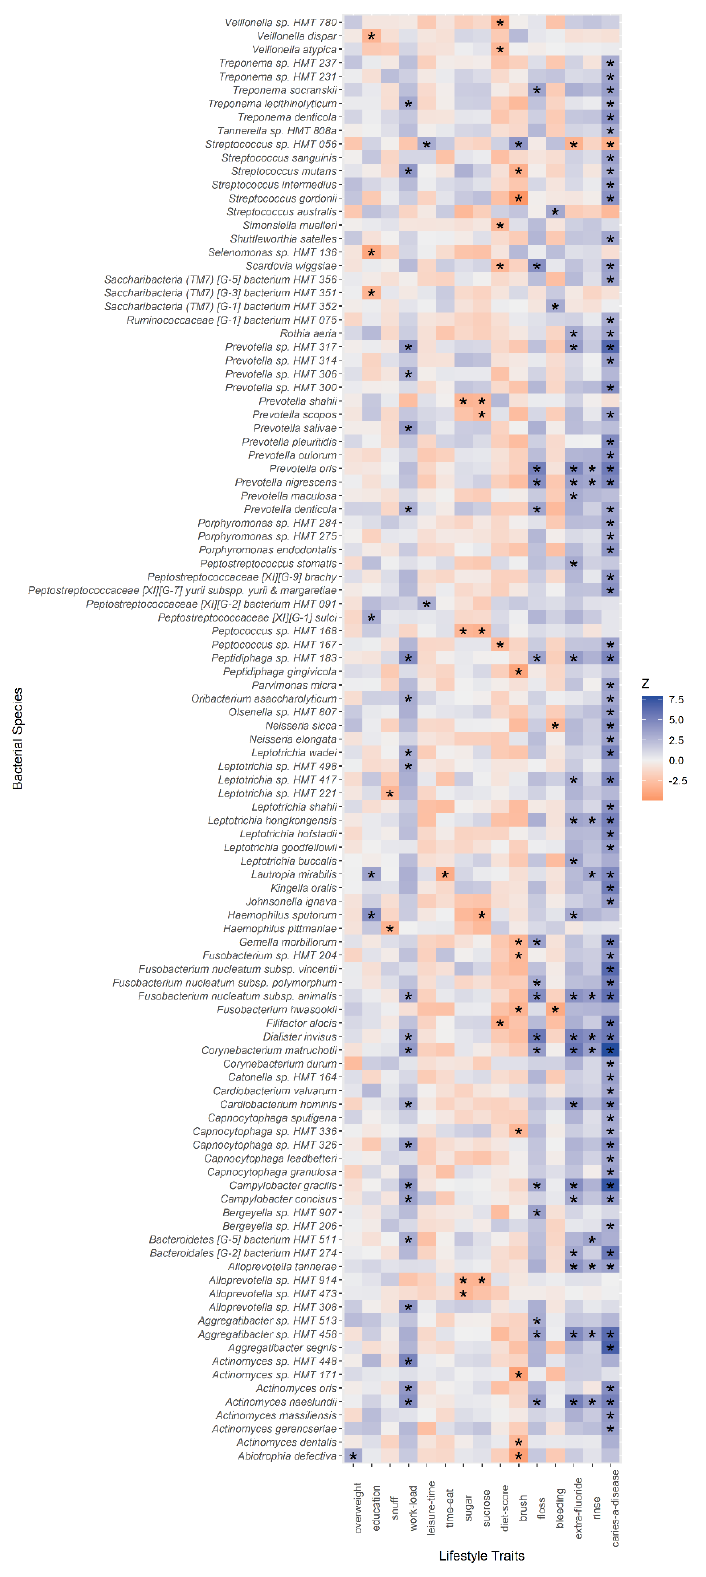
Figure 3. Association between lifestyle traits and relative abundance of common bacterial species. Z scores indicate the strength and direction of association and are obtained from linear regression models. Associations with Benjamini–Hochberg-adjusted p values < 0.05 are indicated with (*). All models included adjustment for age, sex and highest educational level.